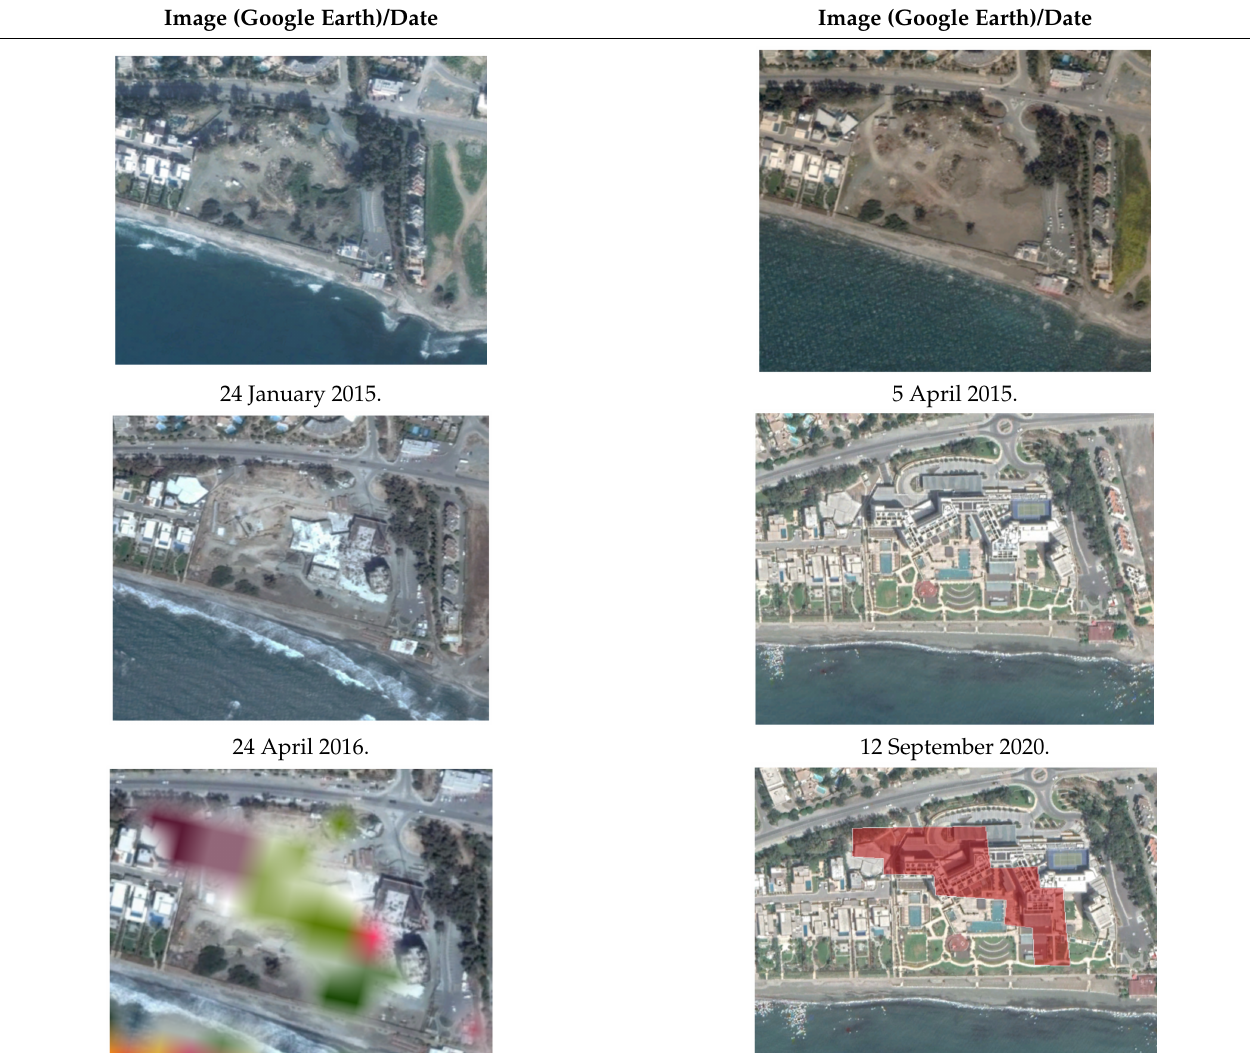
Table 2. Change detection results from just 700 m on the eastern part of the Amathus hill, using the 2015 Sentinel-1 images. A large construction was erected in the